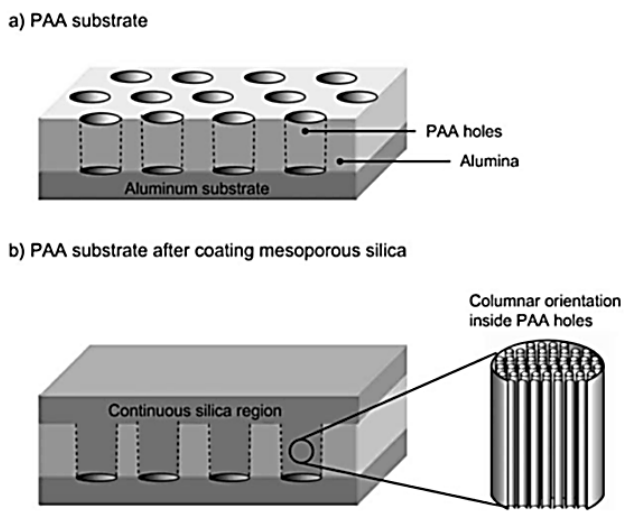
Figure 13. Diagram showing the formation of vertically aligned nanoholes by confining the LLC precursor into the nanoholes on polyacrylic acid (PAA) substrate [96] (Reprinted with permission from [96]. Copyright (2009) WILEY-VCH Verlag Gmbh & Co.).